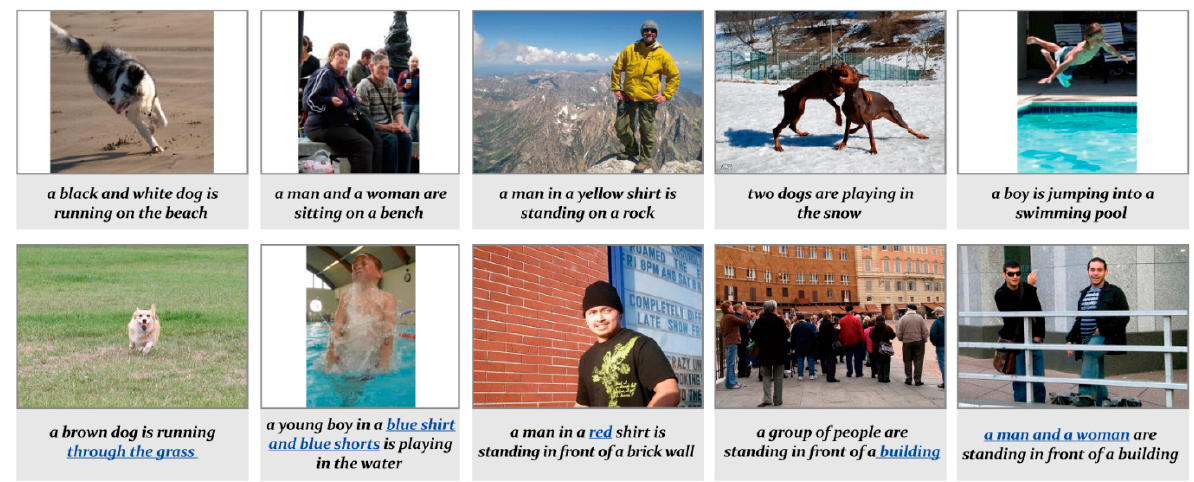
value of 0 in the attack. Figure 7 presents the encrypted images with some pixels having been randomly excluded. Only the amplitude images are shown in Figure 7. Table 7 lists the CIDEr scores of the models on the test images with some pixels having been randomly